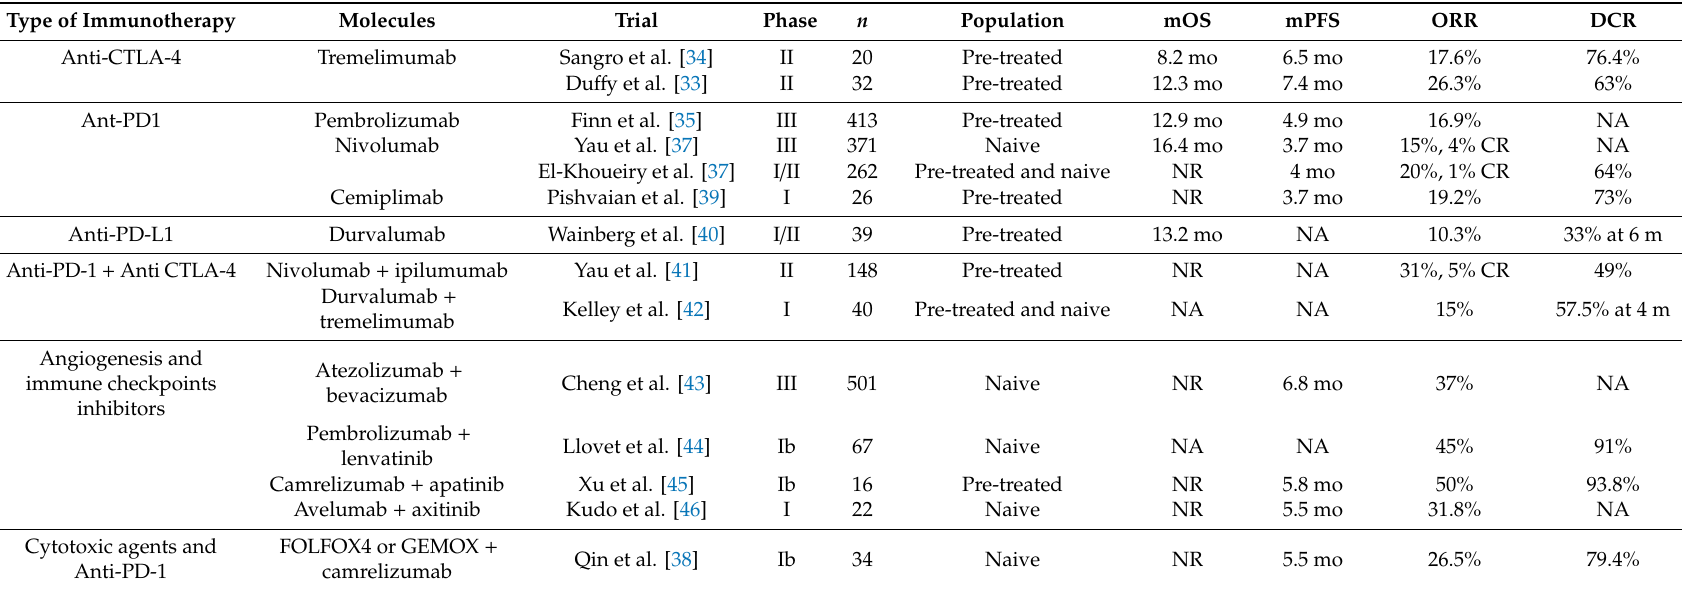
Table 1. Summary of clinical trials of immune therapies (single agent or in combination with angiogenesis inhibitors) in patients with advanced hepatocellular carcinoma (HCC) 1